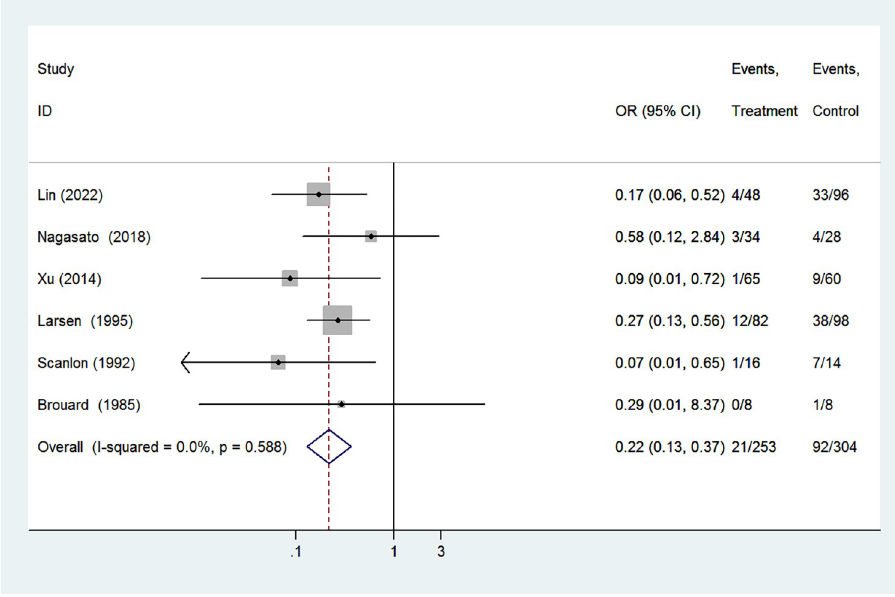
Fig 3. Forest plot of showing the effects of caffeine vs aminophylline on tachycardia.